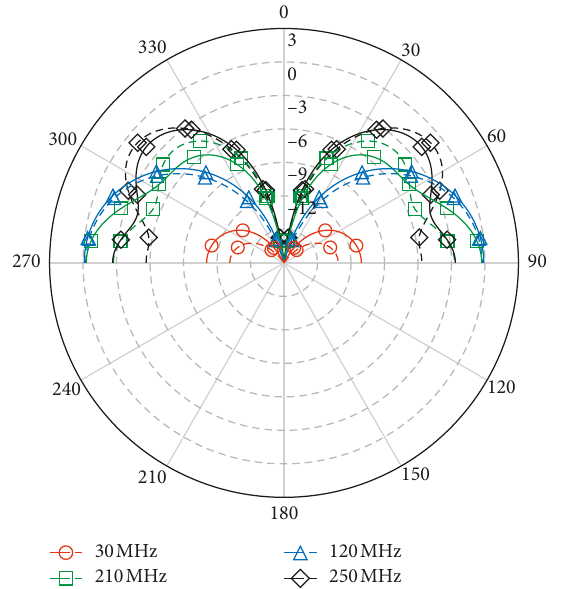
Figure 21: E-plane pattern (solid line for GOA; dashed line for